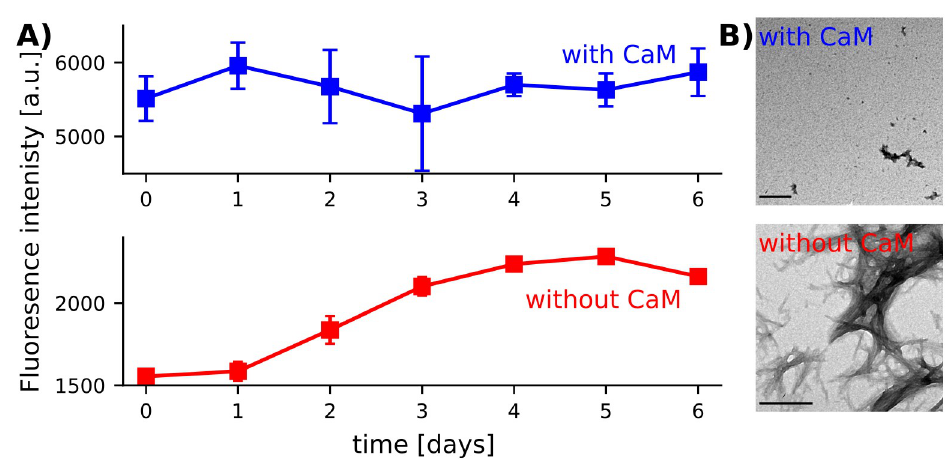
Fig 5. CaM + Ca 2+ prevents fibril formation of Orb2A 1-88 . A) ThT fluorescence kinetics of Orb2A 1-88 alone (red) and Orb2A 1-88 with CaM + Ca 2+ at a 1:1 molar ratio (blue). Error bars representing the standard deviation of three biological replicates are shown in case they are larger than the marker. The fluorescence in the presence of CaM is high because CaM + Ca 2+ induces Tht fluorescence on its own. B) EM images of samples as described in A, taken after 9 days of